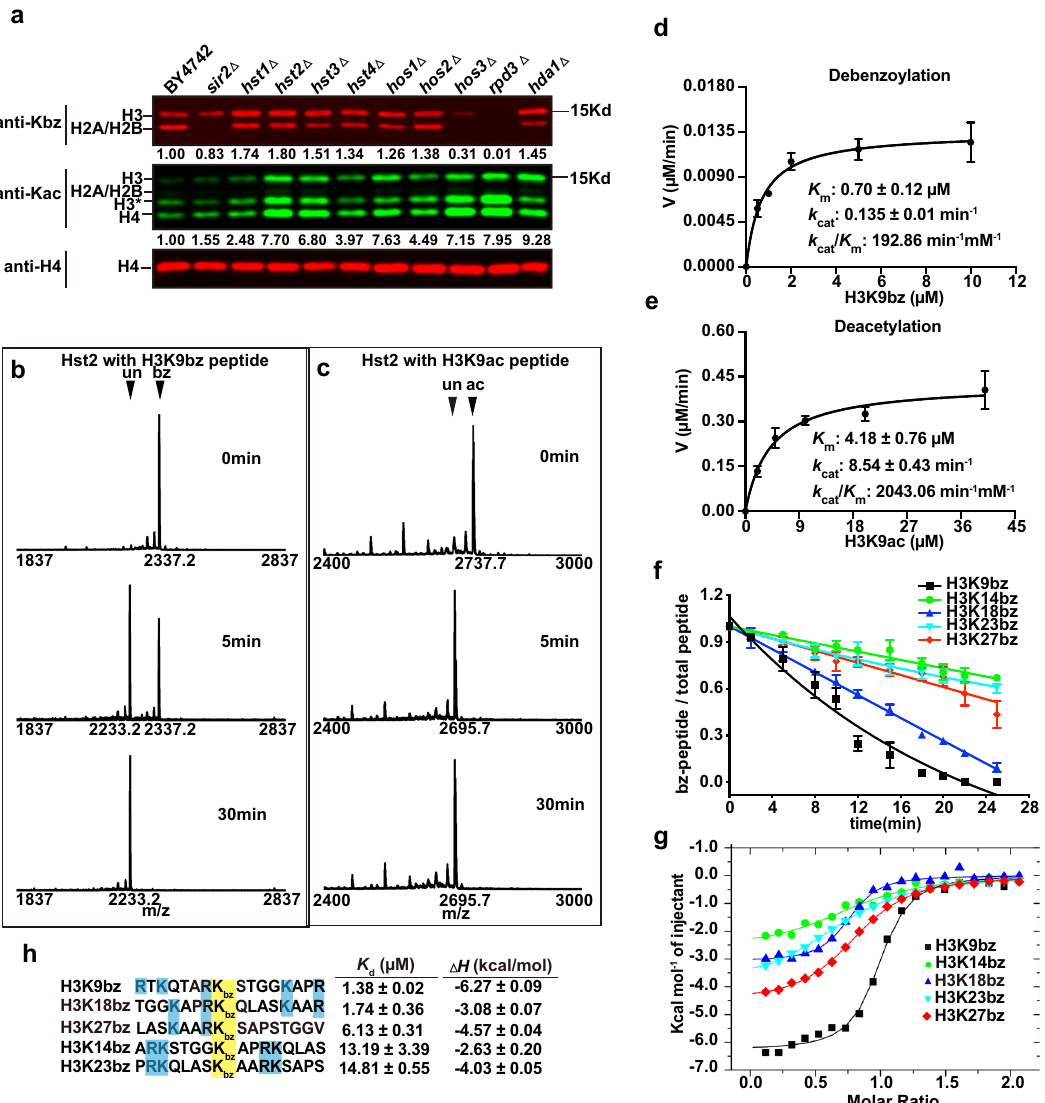
Fig. 3 Hst2 is a histone debenzoylase. a Fluorescence quantitative western blot analysis comparing the Kbz and Kac levels in WT (BY4742) and ten HDAC-deletion strains. The fl uorescence signals from mutant strains were normalized by setting the WT fl uorescence signal to 1.0 and were labeled in the image. The H3* represents clipping H3. Source data are provided in the Source Data fi le. b Debenzoylase activity of Hst2 FL protein (2 μ M) with H3K9bz peptide (10 μ M) shown by the representative MALDI-TOF spectra at 0, 5, and 30 min. The peaks for H3K9bz (bz, m/z 2,337) and unmodi fi ed (un, m/z 2,233) products are labeled. c Deacetylase activity of Hst2 FL protein (0.5 μ M) with H3K9ac peptide (10 μ M) shown by the representative MALDI-TOF spectra at 0, 5, and 30 min. The peaks for H3K9ac (ac, m/z 2,737) and unmodi fi ed (un, m/z 2695) products are labeled. d The Michaelis-Menten plot for Hst2 fi xed at 0.1 μ M with varied H3K9bz peptide concentrations. Data are presented as mean ± SD, n = 3 biological independent measurements. Source data for panels ( d , e ) are provided in the Source Data fi le. e The Michaelis – Menten plots for Hst2 fi xed at 0.05 μ M with varied H3K9ac peptide concentrations. Data are presented as mean ± SD, n = 3 biological independent measurements. f Hst2-mediated debenzoylation reaction monitored by time-resolved MALDI-TOF mass spectrometry. The Y -axis represents the percentage of Kbz peptide in total peptides calculated from the MALDI-TOF spectra. Data are presented as mean ± SD, n = 3 biological independent measurements. Source data are provided in the Source Data fi le. g ITC binding curves for Hst2 interaction with different Kbz peptides. h Sequence alignment of benzoylated H3 peptides used in the current study. The alignment is centered on the target lysine (yellow). Positively charged R/K residues are shown in blue. The dissociation constants ( K d ) and enthalpy changes ( Δ H) derived from the ITC assay (panel g ) are electrostatic interactions in coordinating the recognition of histone Benzoylated lysine 9 (K9bz) is snugly inserted into a relatively substrates with Hst2 (Fig. 4e, f). Interestingly, a series of Hst2 hydrophobic tunnel (Fig. 4d) and adopts the same geometric residues (D68, D70, D187, D190, E194, E236, E237) form an acidic con fi guration of H4K16ac as seen in the Hst2-H4K16ac structure ring on the surface of Hst2 for basic histone binding, and these (Fig. 4g). In H3K9bz- and H4K16ac-bound structures, both acidic residues are not conserved in other class III HDACs aliphatic side chains of lysine residues form the same van der (Supplementary Fig. 4k), suggesting that other class III HDACs Waals interactions with Hst2 H135, V182, F184, L188, and V228. may have different substrate speci fi cities from Hst2. The backbone amides of H3K9 and H4K16 identically coordinate